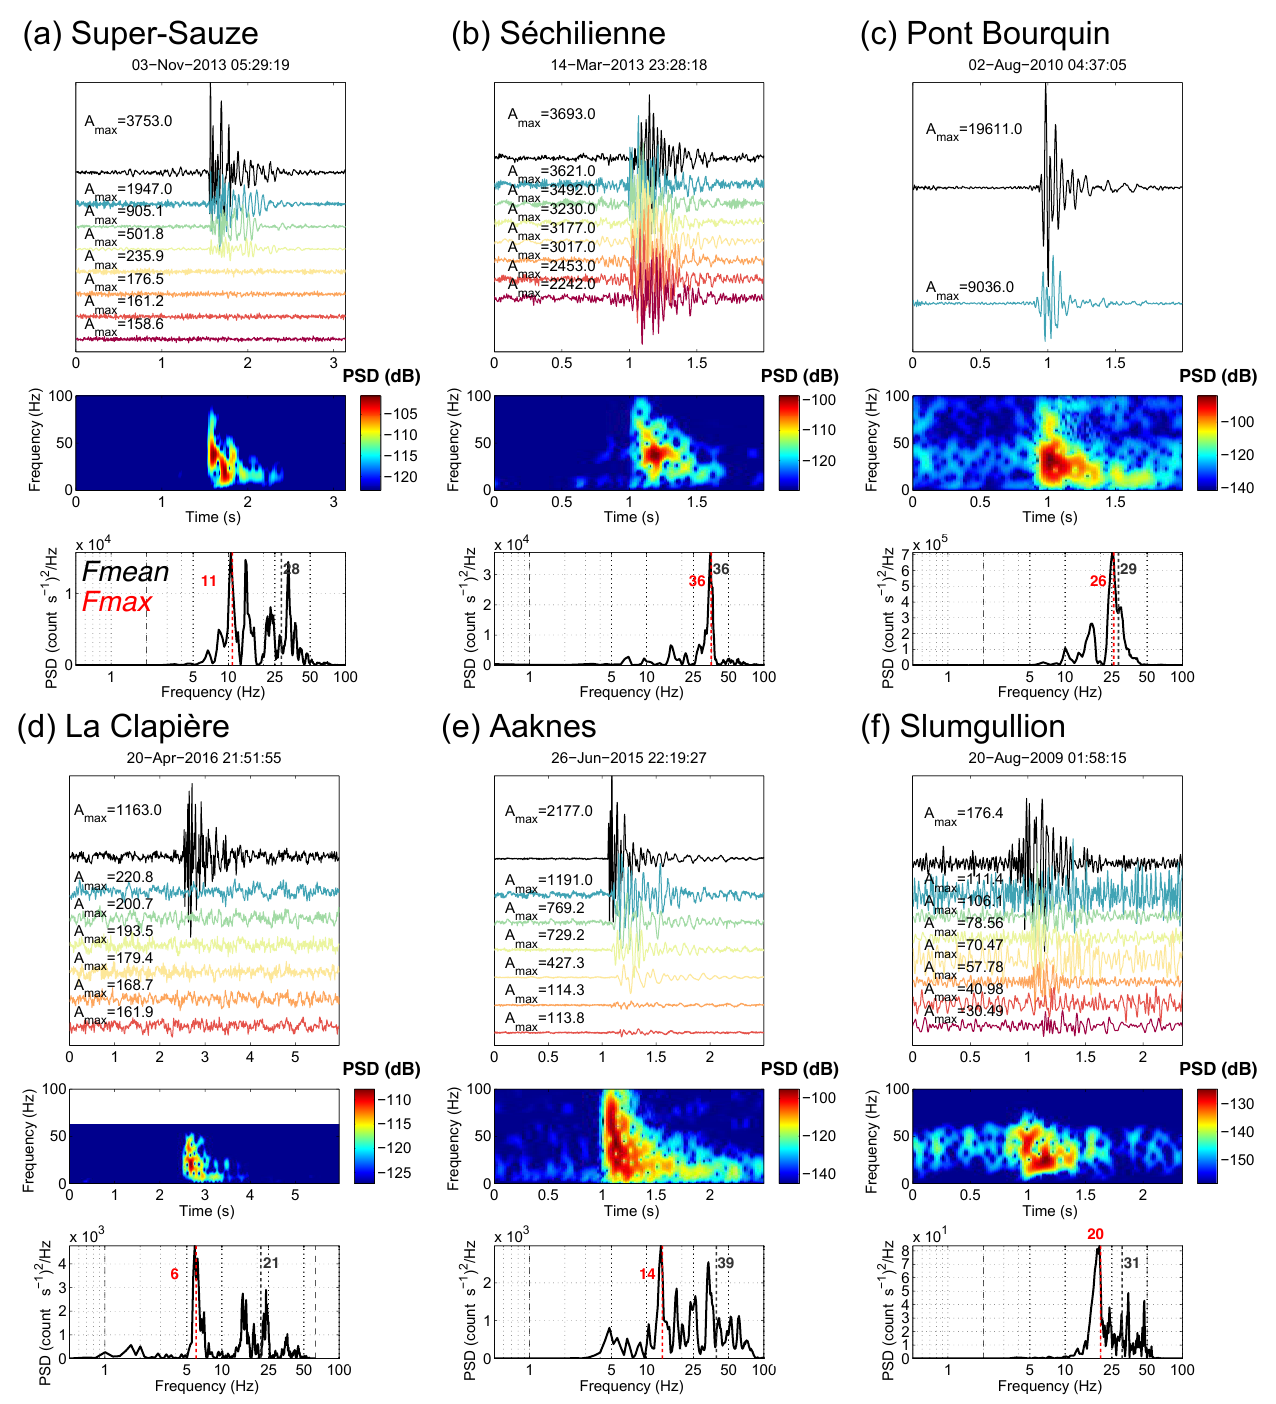
Figure 7. High-frequency slopequakes recorded at the (a) Super-Sauze (Provost et al., 2017a), (b) Séchilienne (Helmstetter et al., 2011; RESIF/OMIV, 2015), (c) Pont Bourquin, (d) La Clapière, (e) Aaknes and (f) Slumgullion (Gomberg et al., 2011) slopes. See Fig. 2 for a description of the figure. Note that for the Slumgullion signals (f) , the amplitudes are expressed in counts.